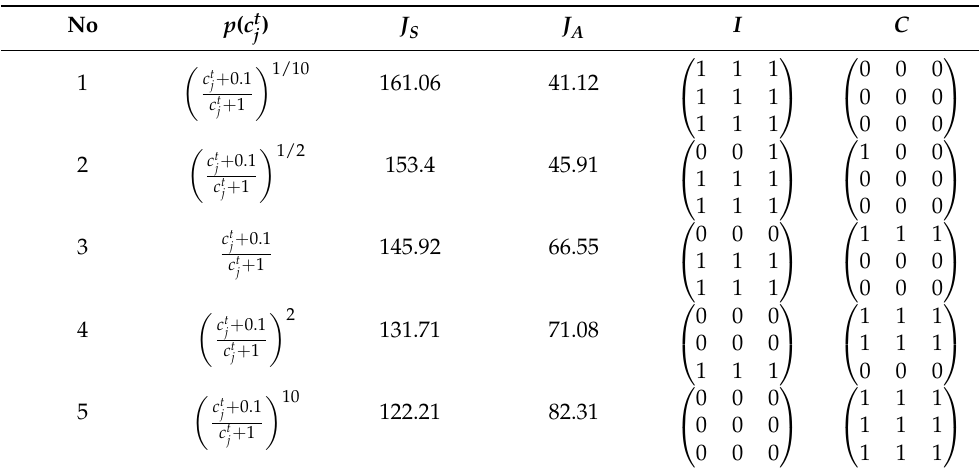
Table 8. Optimal strategies of auction participants and their payoffs depending on the probability of